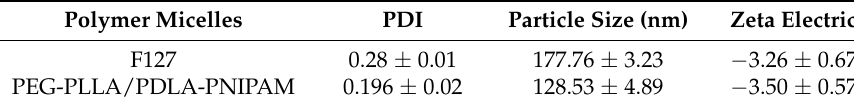
Table 1. Polymer micelle particle size and potential measurement ( n = 3).